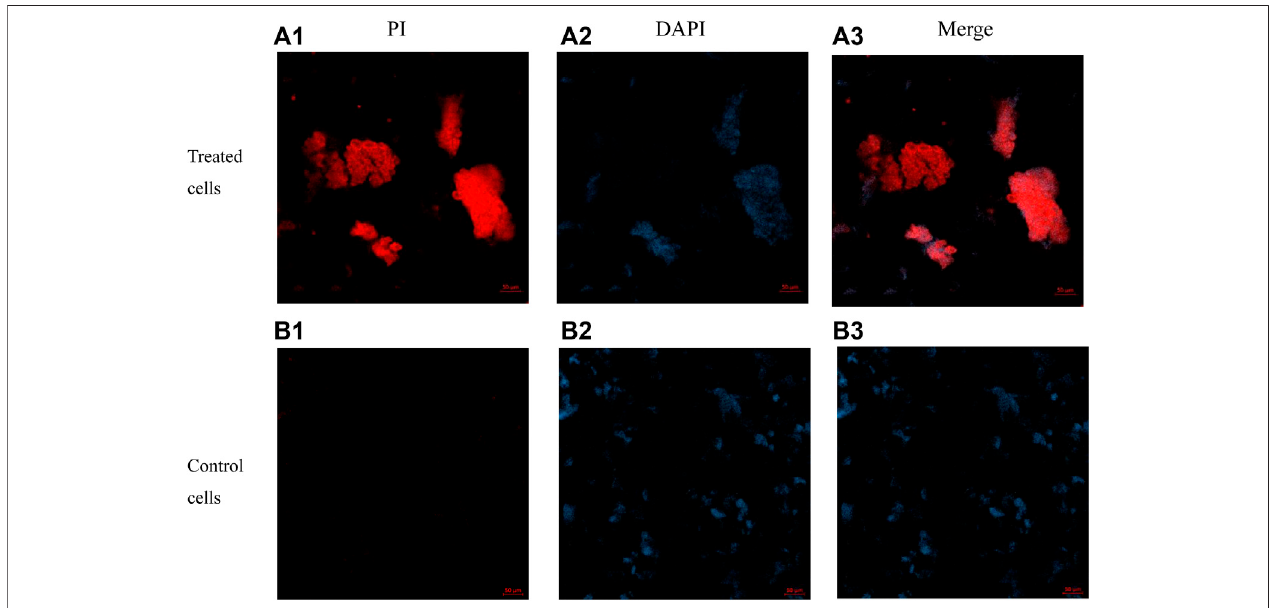
FIGURE 8 | Images of E. coli cells treated with 4 × MIC of E6 for 2 h post-incubation acquired by concentric laser scanning microscopy. images (a1 – a3) of E6 treated cells stained with PI, DAPI and merged. images (b1 – b3) of control cells stained with PI, DAPI and merged.